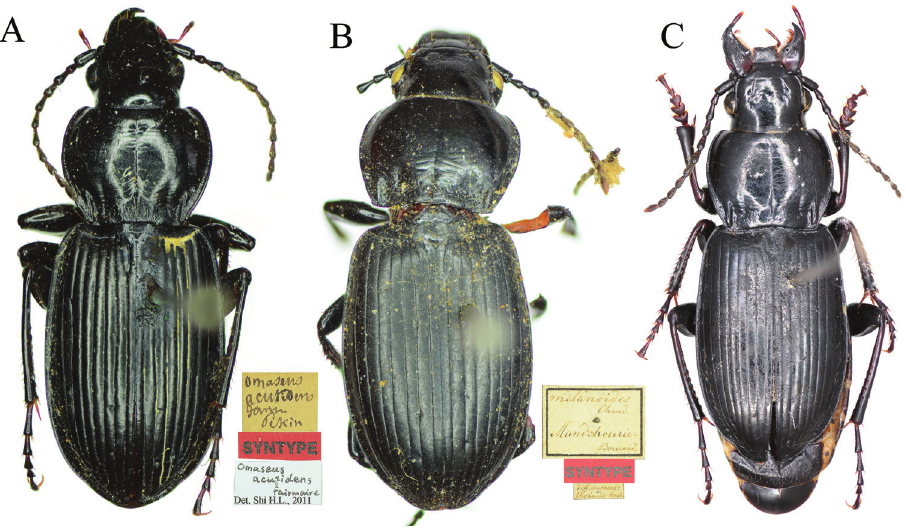
Figure 14. Habitus of Pterostichus ( Feroperis ) spp. from China. A P. acutidens (Fairmaire), male syntype (MNHN) B P. melanodes (Chaudoir), female syntype (MNHN) C P. rasilis Park & Kwon, male from Changbai Mountain